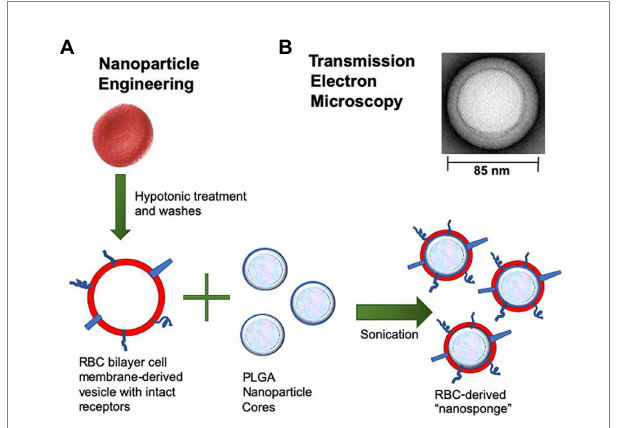
FIGURE 1 Preparation process of RBCM-derived nanosponges. (A) Schematic diagram of the fusion process of erythrocyte membrane and PLGA nanoparticles into nanosponge. (B) Transmission electron microscopy image of a single toxin-absorbing nanosponge. (Koo et al., 2019). RBCM, red blood cell membrane; PLGA, poly(lactic-co-glycolic